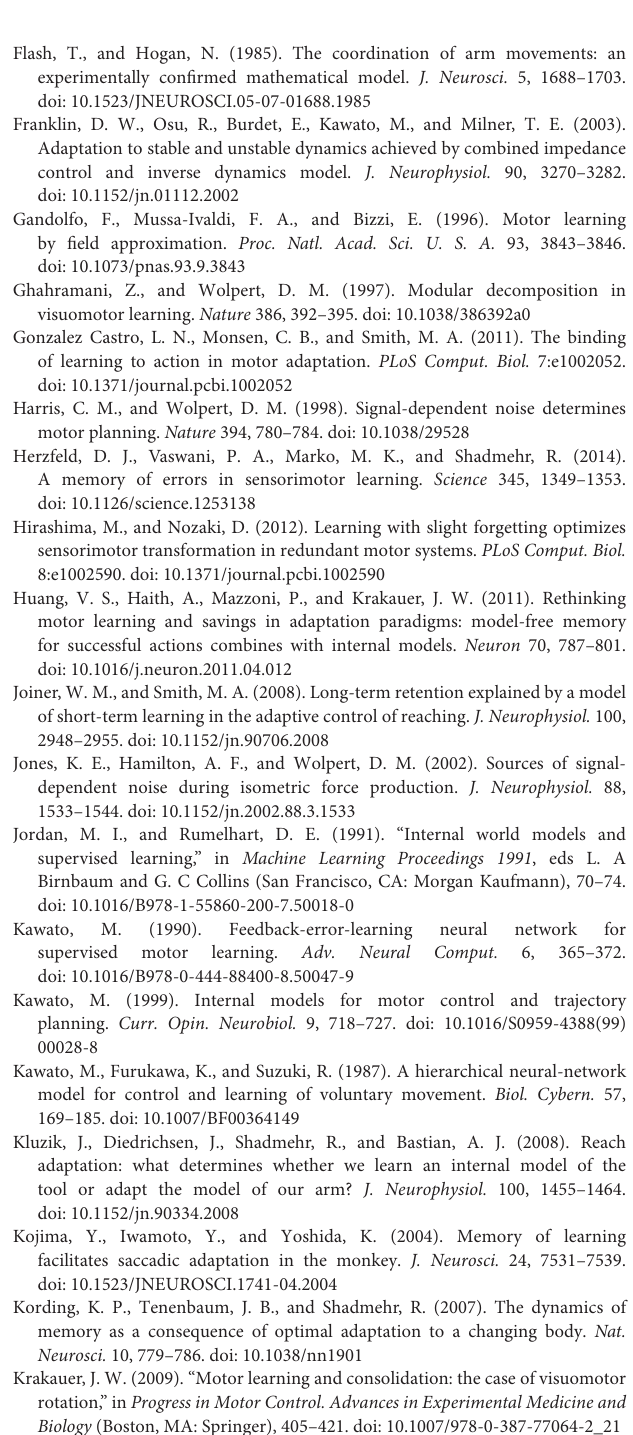
circles represent the start and target positions for the movements (15cm apart). The dotted black line is the ideal straight line. Blue segment is the initial launch of the movement, and red segment is the first 150ms of the initial launch. Solid Black line is the feedback correction phase of the movement where the subject navigated to the target after the initial launch. Note that the feedback correction phase is highly random during the early training and is greatly reduced and systematic during the late